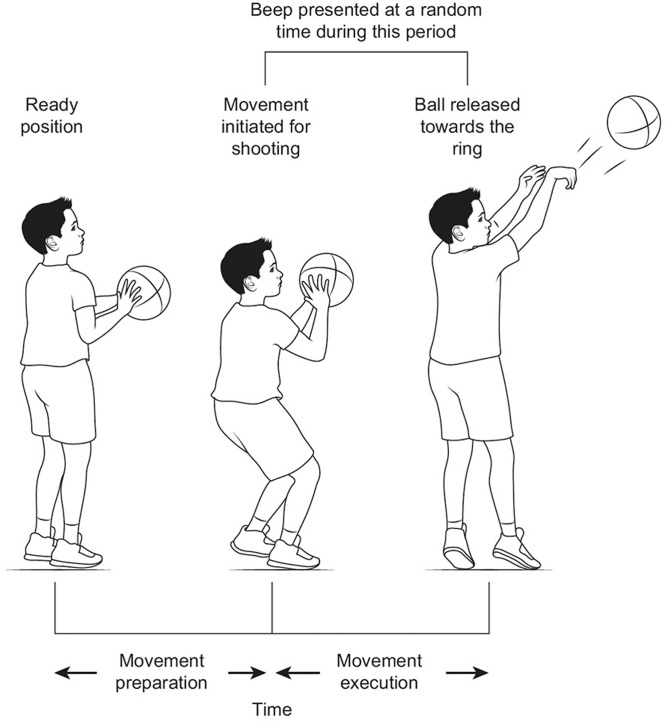
The sequence of events for the probe reaction time (PRT) conditions. Previous studies have differentiated between movement preparation and movement execution (Gray, 2004; Lam et al., 2010a,b). Our study specifically assessed PRT’s during the movement execution phase, which began when children initiated movement to shoot the ball (occurred after bouncing the ball). The beep was 80 ms in duration.